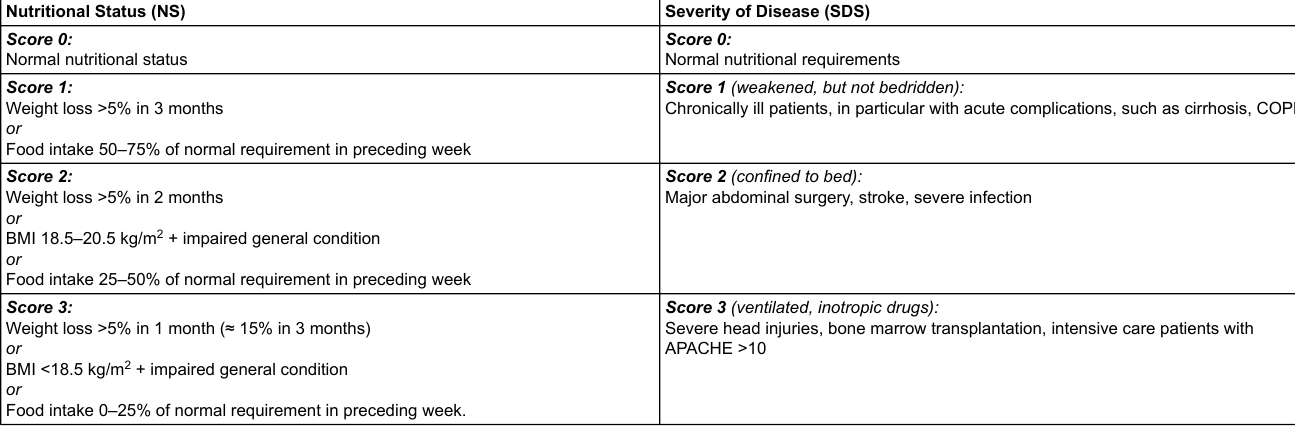
Table 1: Summary of the NRS-2002 Scoring System according to Kondrup et al. (2003) [15]. For the total screening score, add the score of “Nutritional Status” and “Severity of Disease”, patients of age ≥70 receive an extra point. Nutritional Status (NS) Severity of Disease (SDS) Score 0: Normal nutritional status